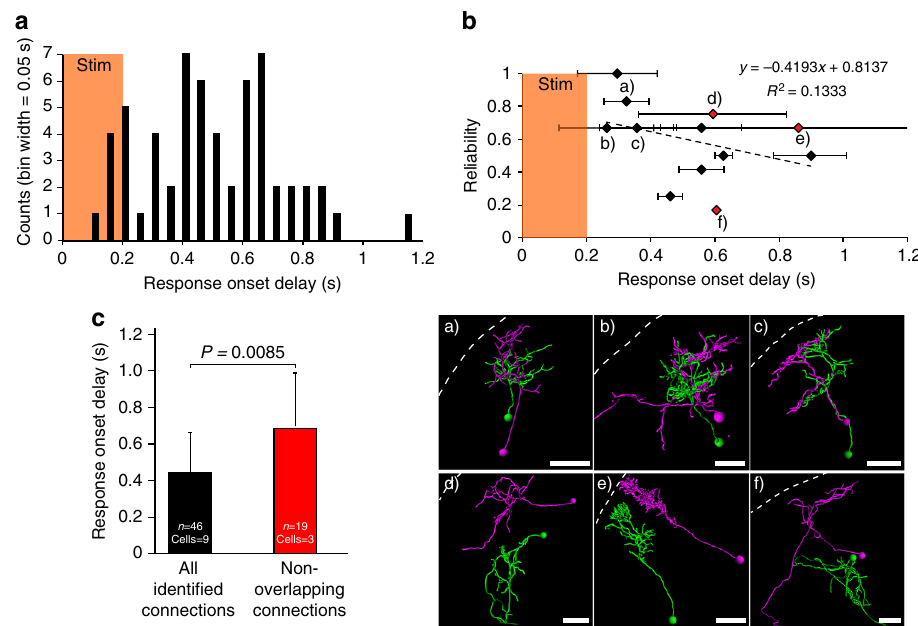
Fig. 5 Quanti fi cation of response latencies and reliabilities. All data are derived from 5 dpf larvae expressing Optobow-nPA, using a sampling rate for calcium signals of < 4.5 ms per frame. a Distribution of all response latencies. Events are grouped in temporal bins of 50 ms. Orange shaded region marks 200 ms of ChrimsonR photostimulation. Number of trials n = 65, number of cells = 12. b Individual cell response reliability vs. response onset latency. For every cell, the average response onset is represented along the X axis, while the ratio responses per trials is plotted in the Y axis. Dashed line represents a linear regression model of the data to evaluate the degree of correlation (coef fi cient of determination is 0.13329). Morphological analysis shown below indicates overlapping (a – c) or non-overlapping (d – f) neurite arbors of the functionally identi fi ed cell pairs. Error bars are SD. Scale bar , 20 µ m. c Average response latencies of three non-overlapping cells ( red data points in b ) compared to all other identi fi ed responding cells. Error bars are